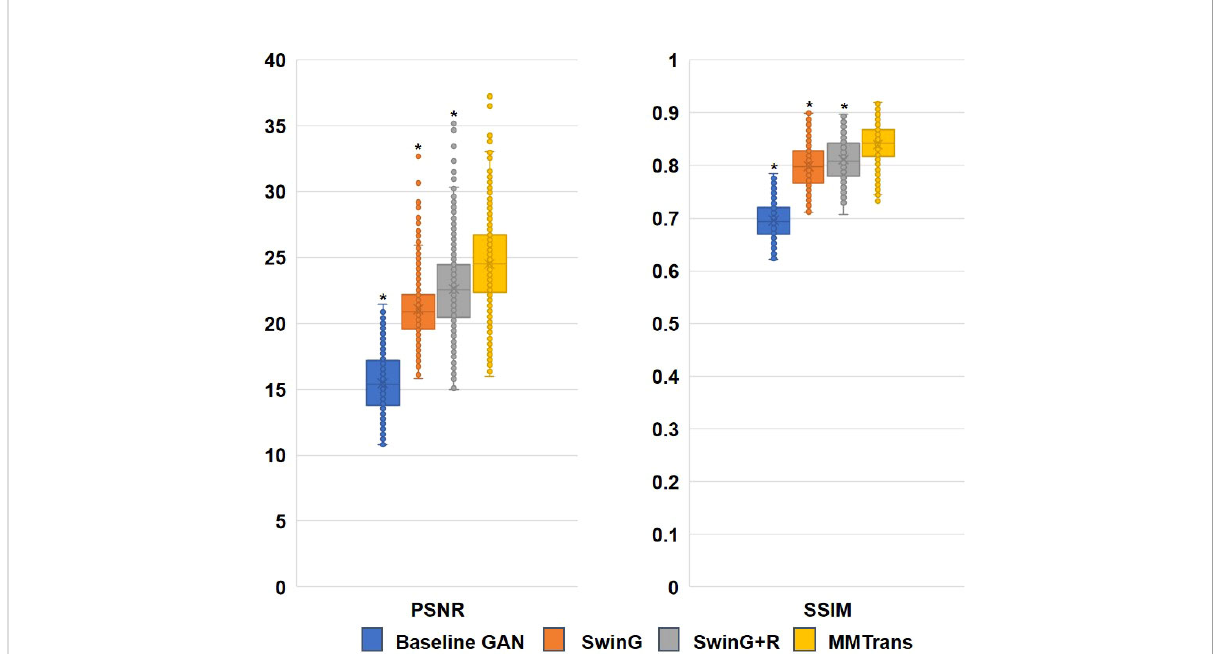
FIGURE 10 Ablation study results with different scenarios on the BraTs2018 dataset. *Signi fi cant difference between different comparison methods and our proposed MMTrans ( p <